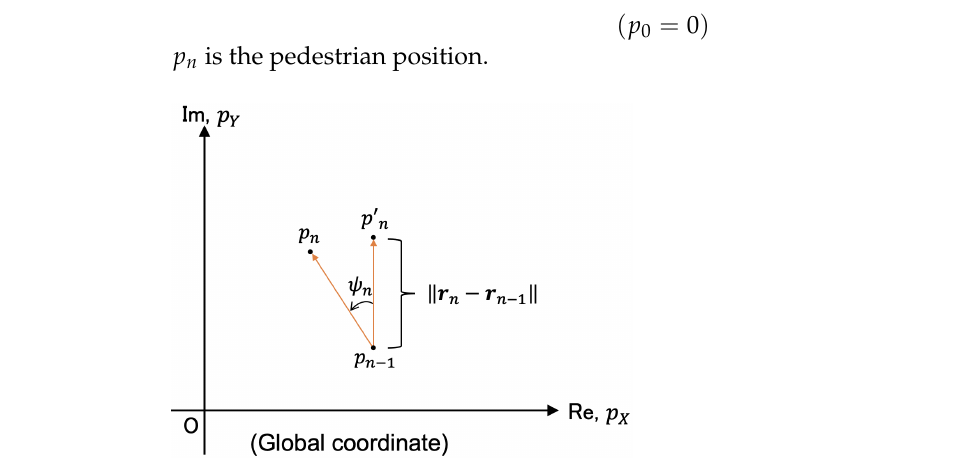
Figure 7. The pedestrian position in the global coordinates ( p n and p n − 1 denote the current pedestrian position and previous pedestrian position, respectively. Coordinate ( p X , p Y ) is the global coordinate of the floor).